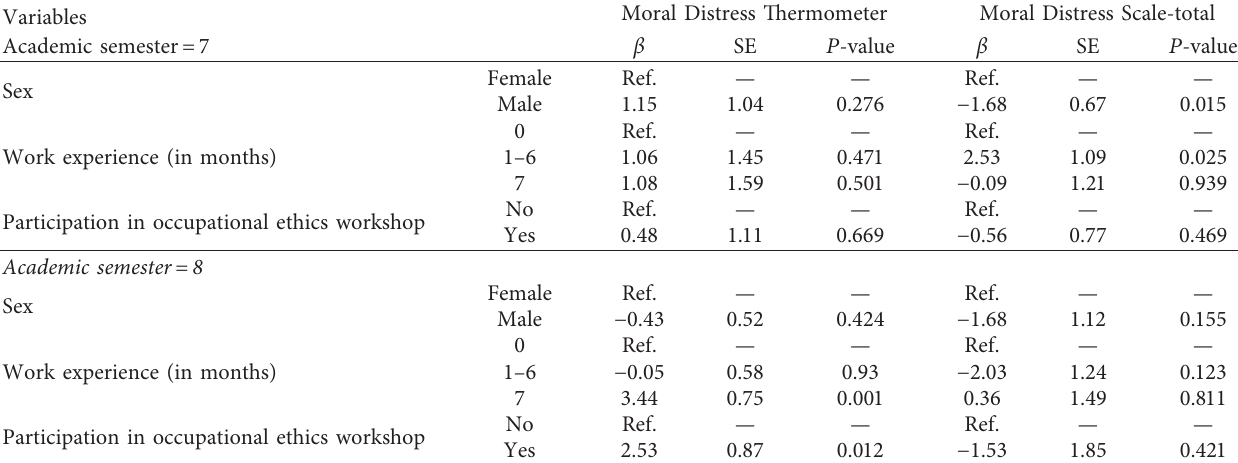
Table 4: Relationship between demographic variables and total MDS-total and MDT based on